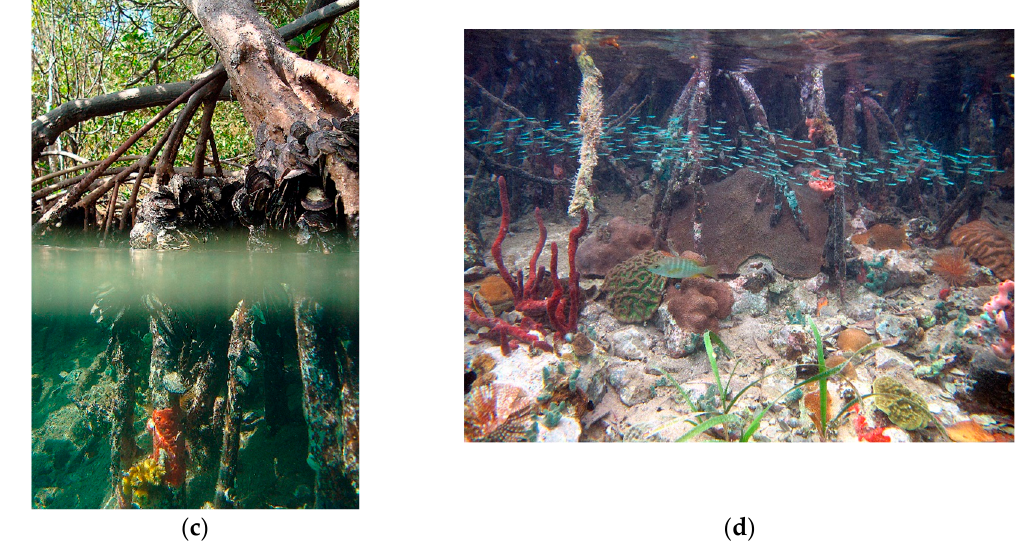
Figure 2. Red Mangroves fringe the shorelines of the bays in Hurricane Hole and their prop roots extend into the clear waters below ( a , b ). Corals grow on and among the prop roots and on nearby hard substrata ( c , d ). All photos in this article were taken by the author.